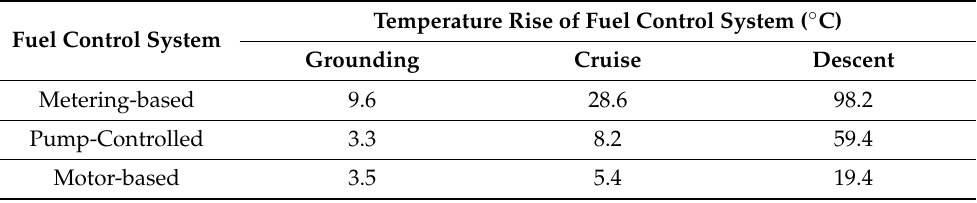
Table 2. Temperature rise of fuel control system under different flight mission